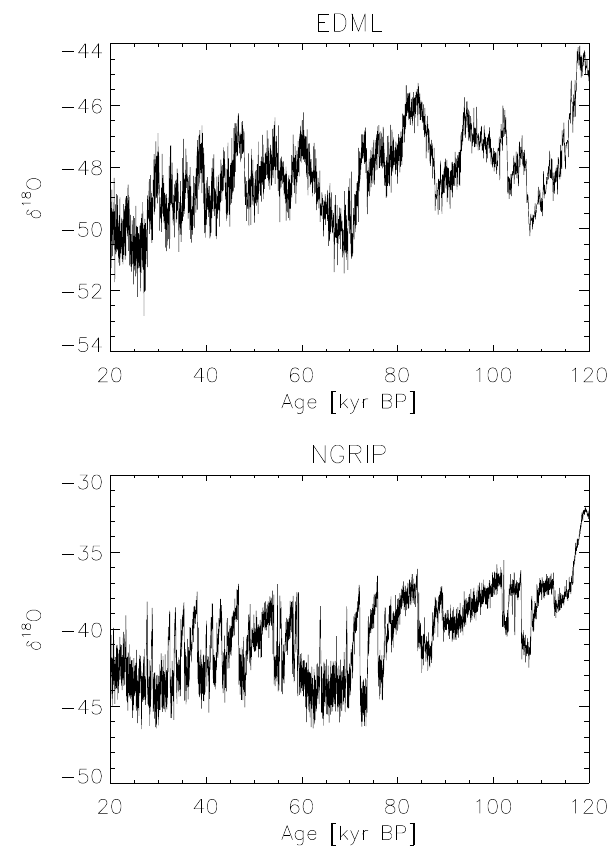
Figure 1. δ 18 O data for the EDML (upper panel) and NGRIP (lower panel) data sets in the period 20–120kyr Fig. 1. (cid:14) 18 O data for the EDML (upper panel) and NGRIP (lower panel) datasets in the period 20 (cid:0) 120 kyr BP